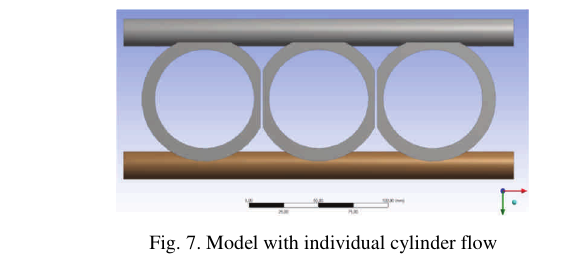
Fig. 7. Model with individual cylinder flow